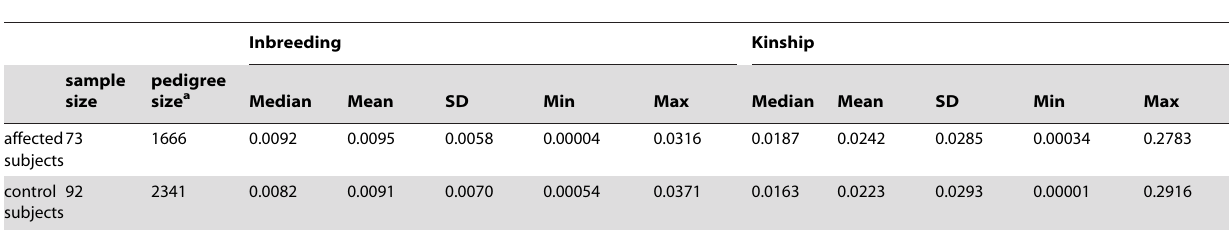
Table 2. Inbreeding and kinship of the case/control sample used in this analysis.